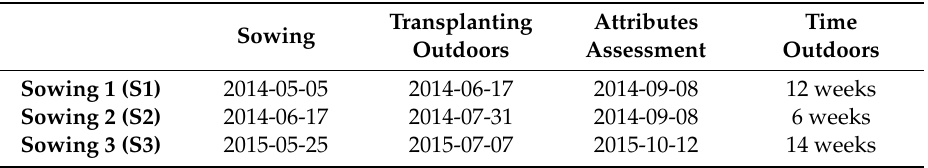
Table 1. Summary of important dates by